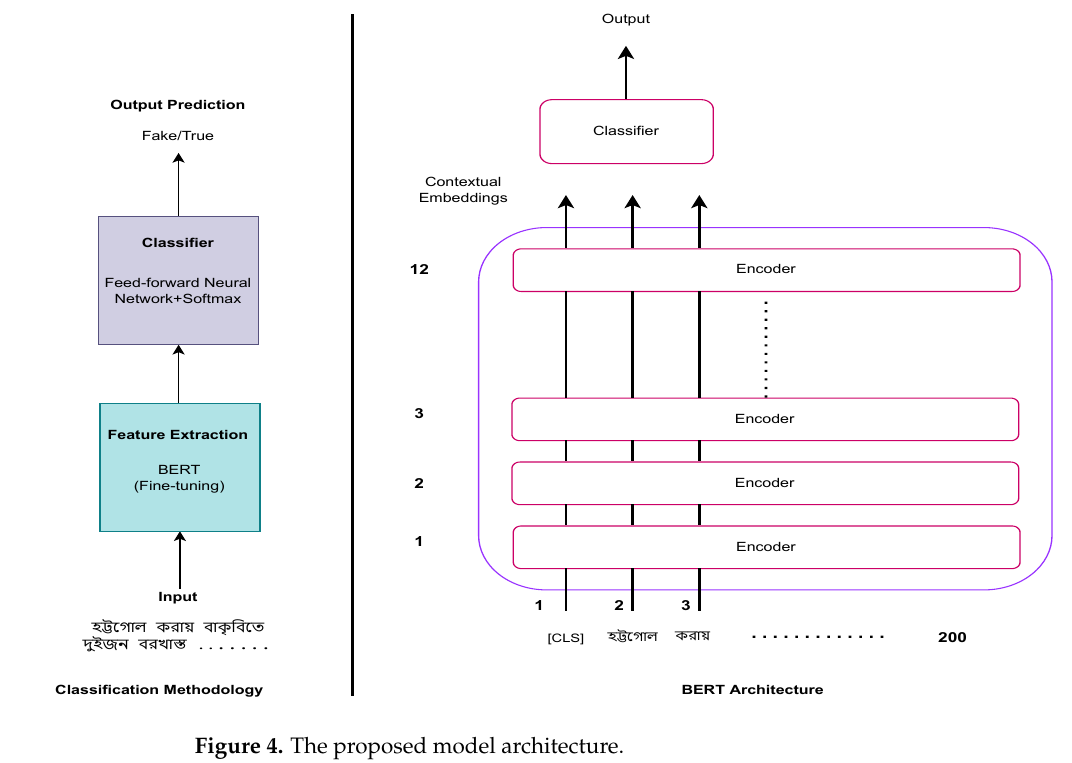
Figure 4. The proposed model architecture.